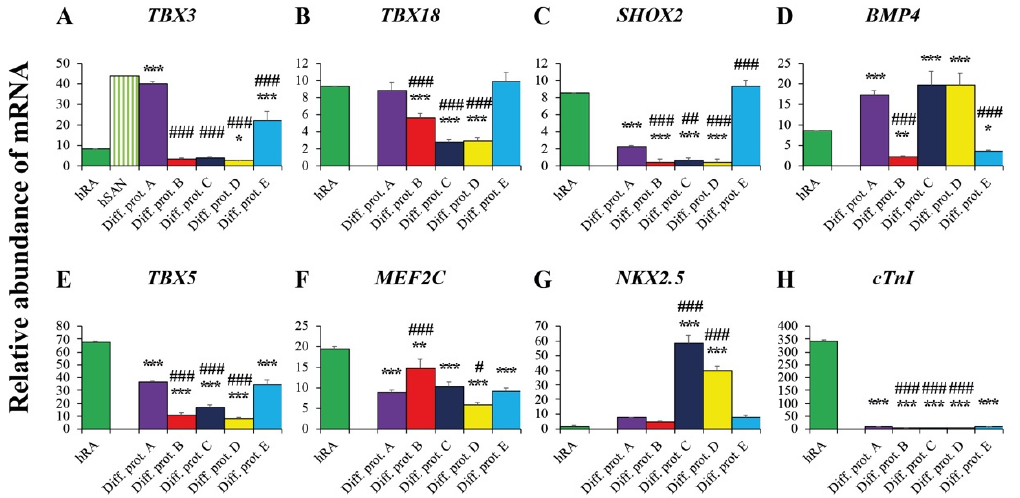
Figure 3. Gene expression of pacemaker-specific and myocardium-related transcription factors in cardiac pacemaker cells. Abundance of mRNA transcripts (in%) relative to gene expression of the housekeeping genes GAPDH/HPRT1/ACTB . ( A – D ): Pacemaker-specific transcription factors. ( E – G ): Myocardium-related transcription factors. ( H ): Myocardial marker troponin I ( cTnI ). Data are